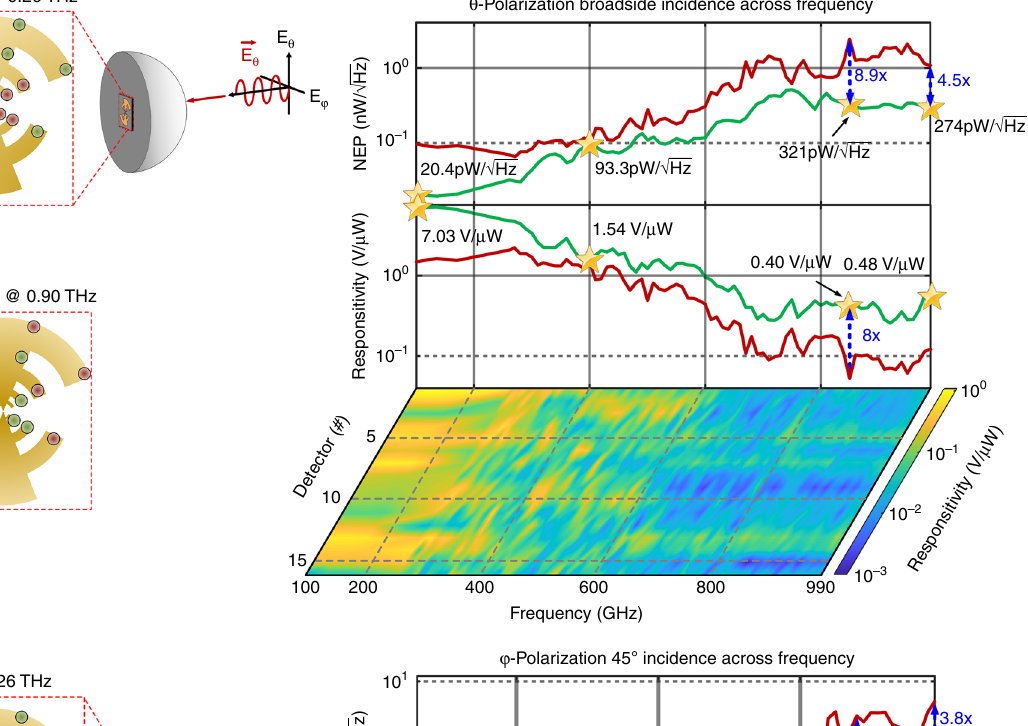
seen, active reprogramming of the sensing surface allows signi fi cant enhancement of sensitivity, including 8.9 and 4.5 times reduction in NEP at 0.86 and 1.0 THz for broadside incidence with θ polarized waves. We can see a similar enhancement in responsivity and reduction in NEP for 45° incidence with ϕ polarized waves, including a 6.2 times reduction